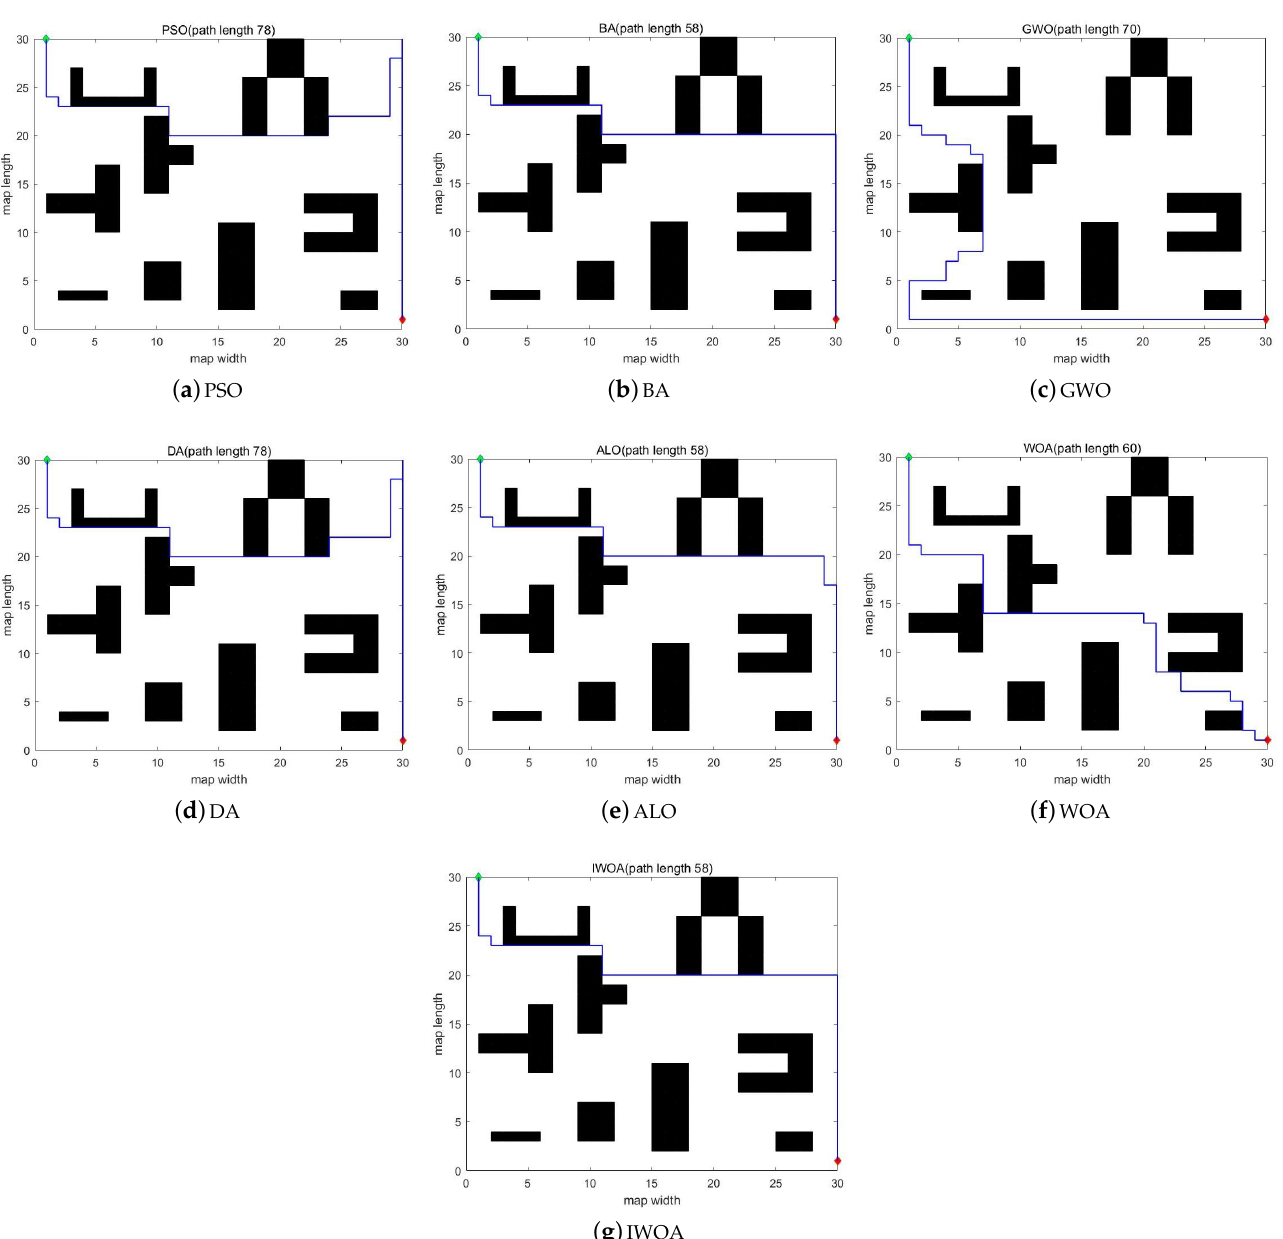
Figure 13. Actual path traces of seven different algorithms on 30 × 30 size